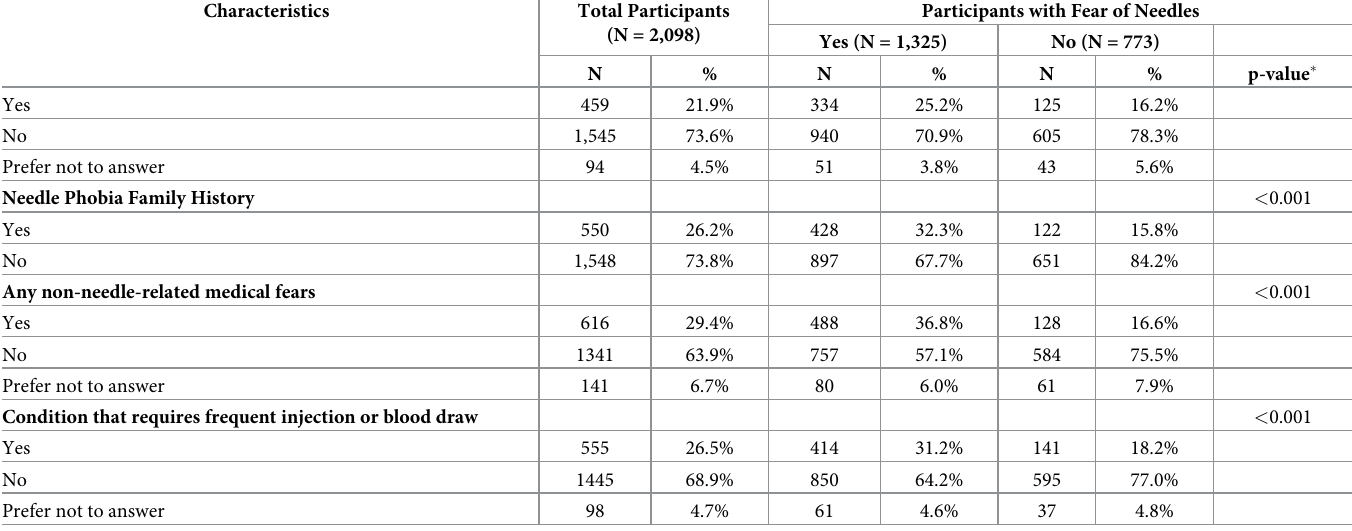
Results for the final model were summarized by odds coefficients for feature importance (Fig 2), confusion matrix (S1 Fig), and classification report (S2 Fig). The most important fea- tures, according to the Logistic Regression model, were non-needle-related medical fears (odds coefficient = 2.14), family history of needle phobia (1.67), and presence of a condition that requires frequent injections or blood draws (1.43). The model had 64% overall accuracy on the training data, and 66% precision, 87% recall, and 75% f1 score for the positive class. For the testing data, the model had 67% accuracy overall, with 71% precision, 86% recall, and 78% f1 score for the positive class.